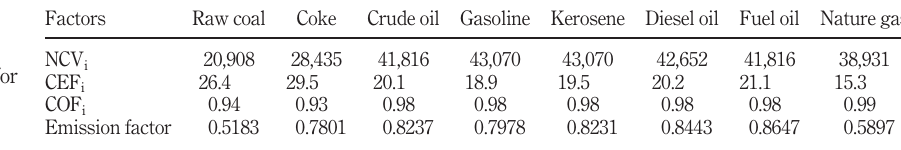
different energy types